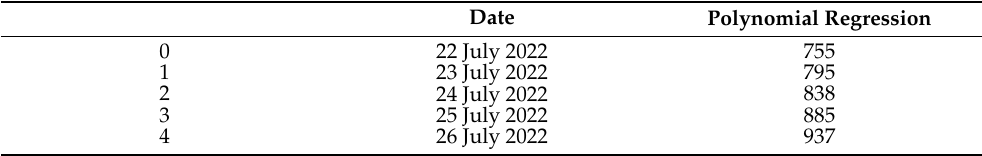
Table 1. Polynomial regression model of confirmed case prediction over five days.